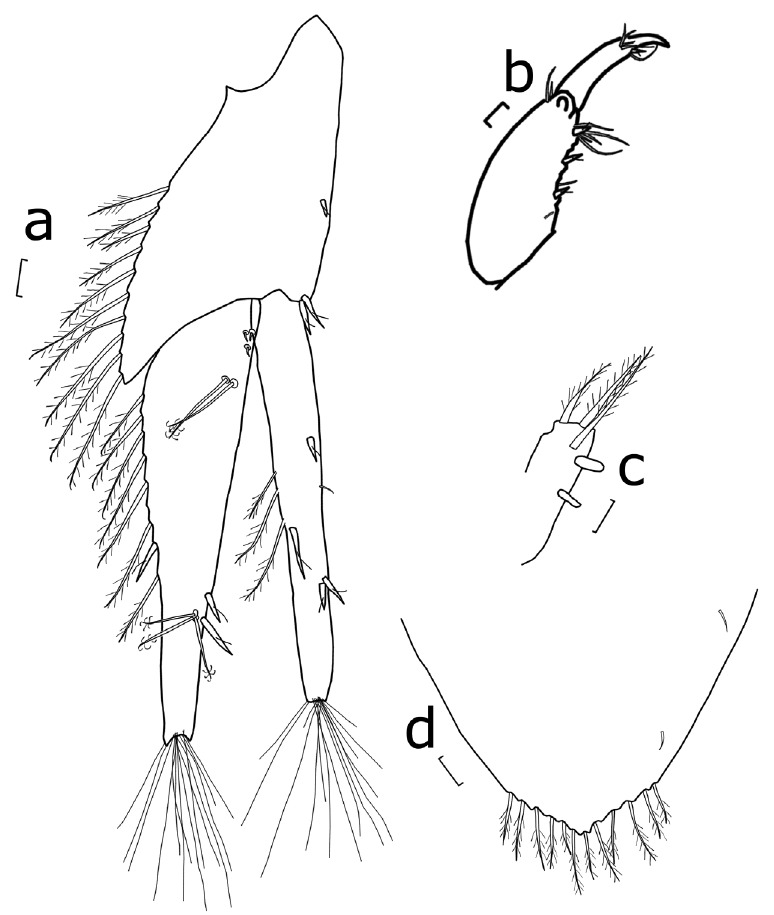
Figure 6. Typhlocirolana cf. gurneyi . a uropod b propodus and dactylus of pereopod I c endite of maxil- liped d apex of pleotelson. scale: a–d = 0.1